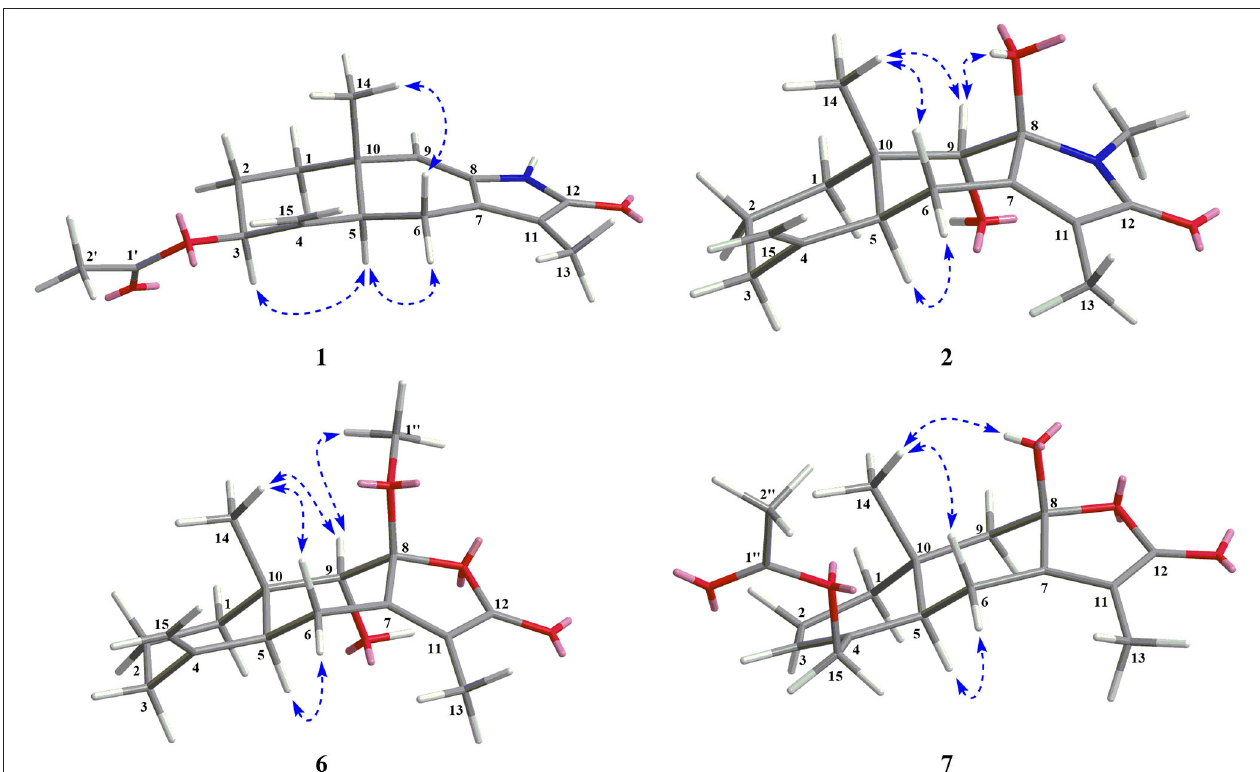
FIGURE 4 | Key NOE interactions for new compounds 1 , 2 , 6 , and 7